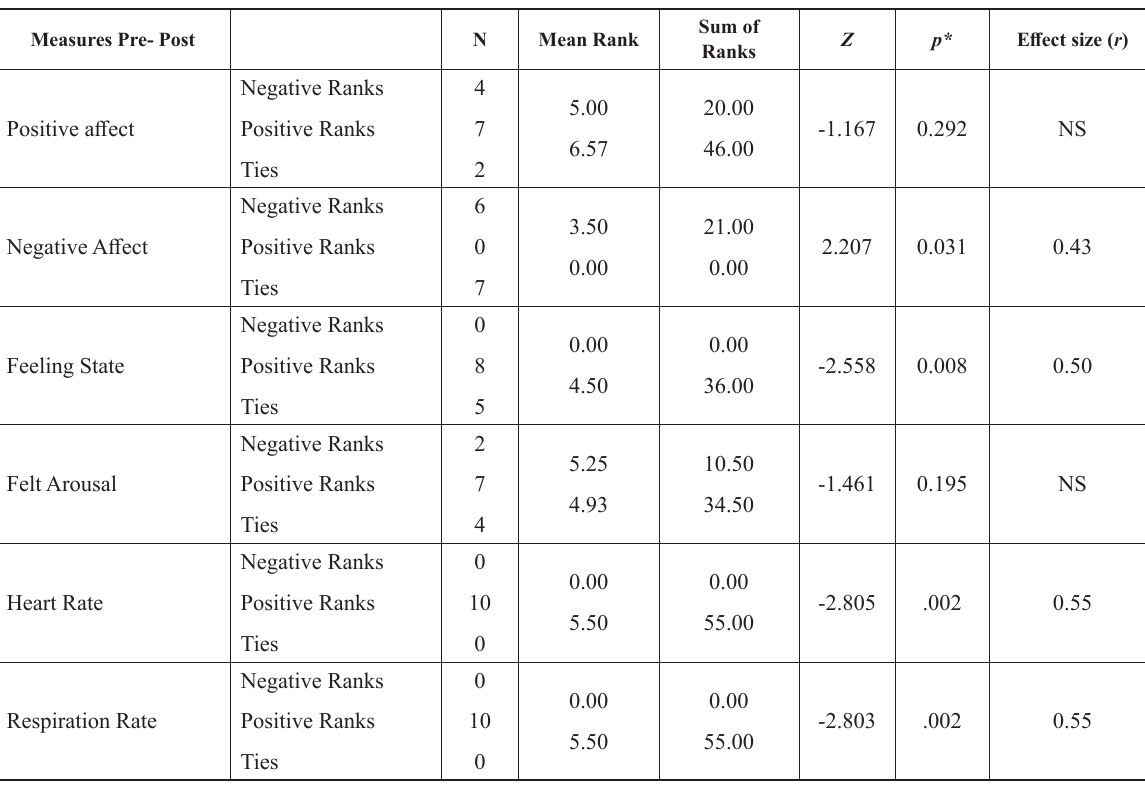
Sum of p* Effect size ( r ) Ranks